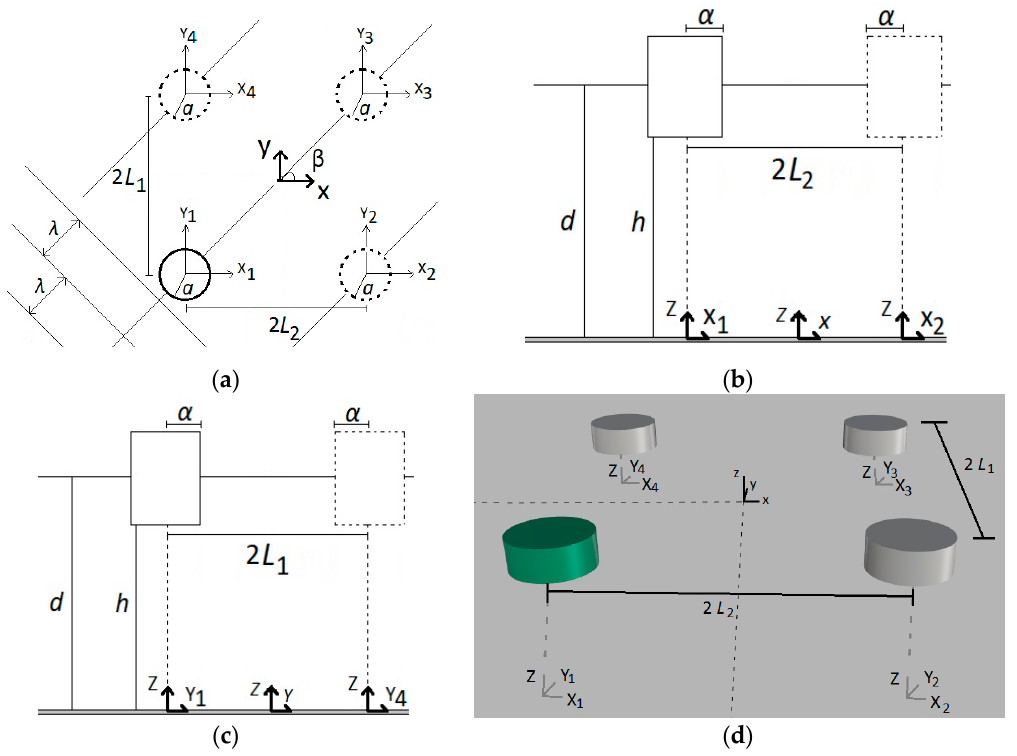
Figure 2. 2-D and 3-D representation of the floaters in the image method: ( a ) plan view in 2-D; ( b ) side view − xz in 2-D; ( c ) side view − yz in 2-D. The image devices are denoted dashed; ( d ) side view − xyz in 3-D. The image devices are depicted in gray color. The dashed lines in black denote the location of the orthogonal breakwater.